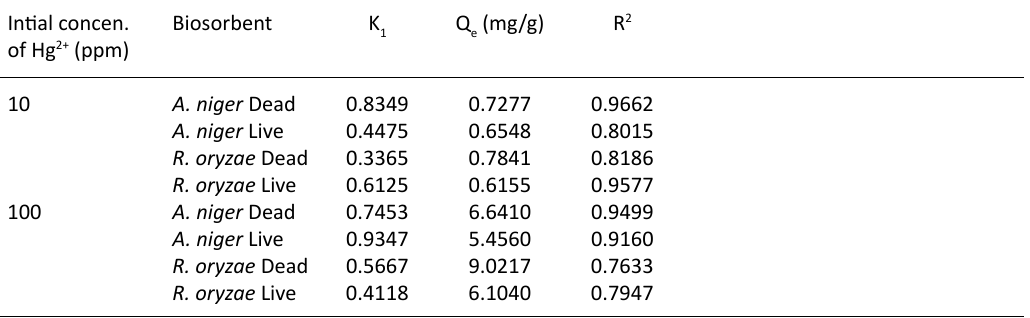
Table 2. The kinetic data of Pseudo-second-order reaction for live and dead R.oryzae and A.niger Intial concen.